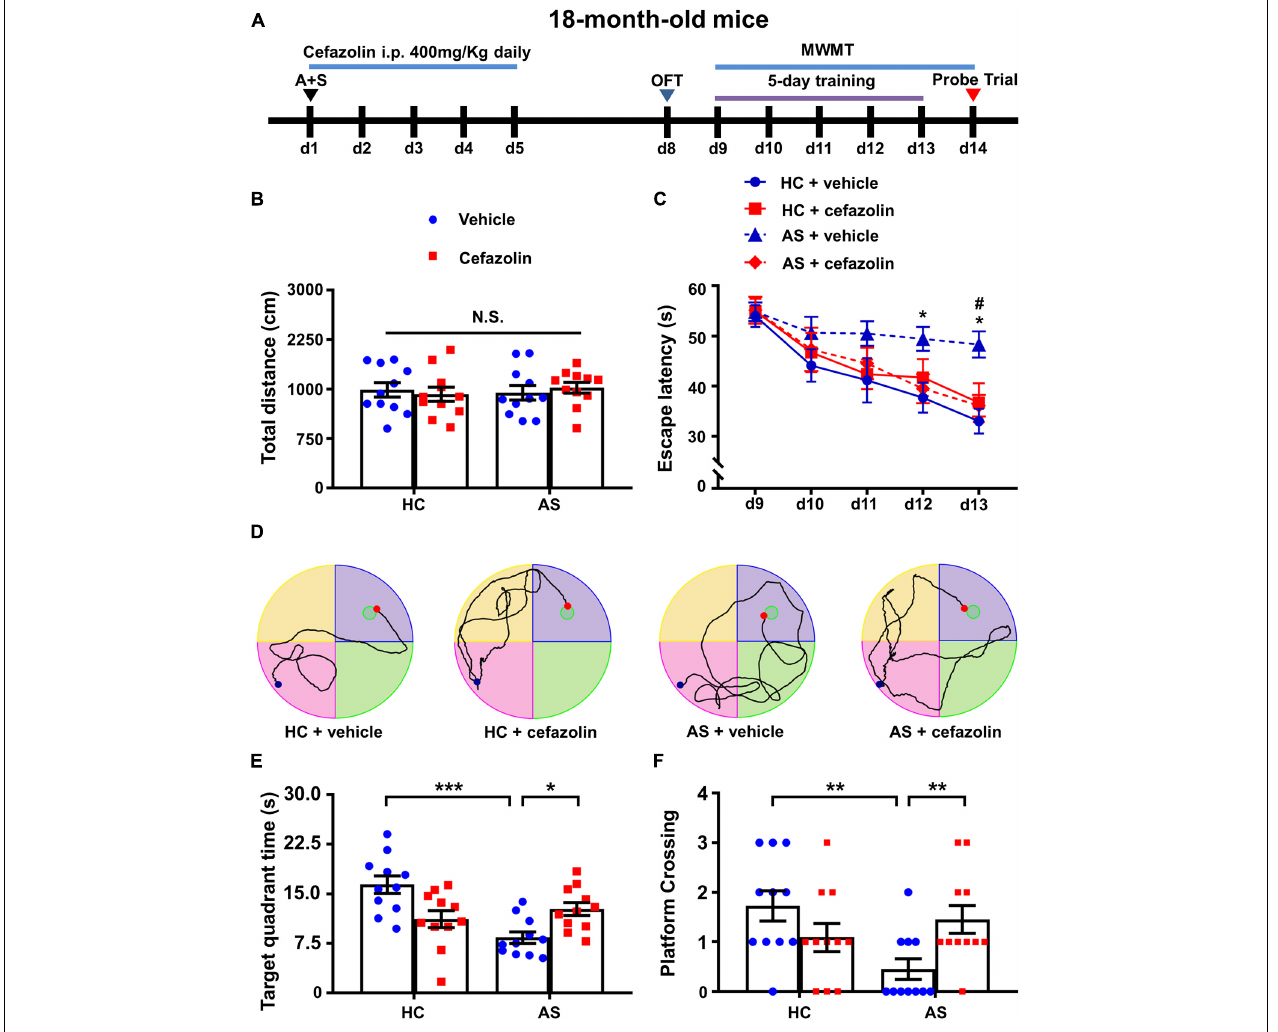
FIGURE 5 | Perioperative use of cefazolin attenuated cognitive dysfunction induced by AS. (A) The schematic of Experiment II. AS was performed on day 1, and cefazolin (400 mg/kg, i.p.) was administered at 0.5 h before the surgery (d1) and once each day for 4 days (d2–d5). OFT was performed on day 8. MWMT was performed on day 9–14. (B) Total distance in OFT. (C) Escape latency of training: AS + Vehicle vs. HC + Vehicle, * P < 0.05; AS + Vehicle vs. AS + Cefazolin, # P < 0.05. (D) Representative traces graphs (the last day of training) of mice in the four groups. (E) Target quadrant time: * P < 0.05 or *** P < 0.001. (F) Platform crossing: AS + Vehicle vs. HC + Vehicle, U = 19, ** P < 0.05; AS + Vehicle vs. AS + Cefazolin, U = 23.50, ** P < 0.05. Data are shown as mean ± S.E.M. ( n = 11 in each group). AS, anesthesia and surgery; d, day; HC, healthy control; MWMT, Morris water maze test; N.S., not significant; OFT, open field test.